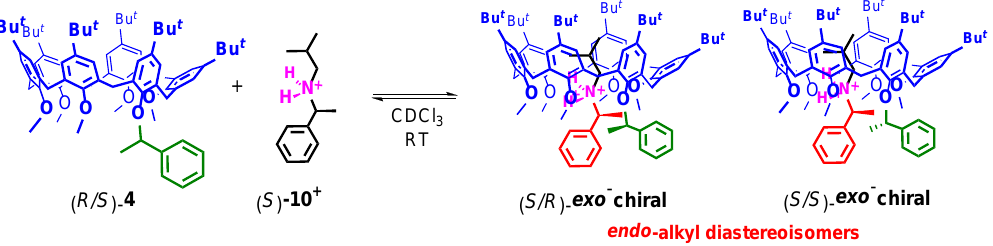
Scheme 7. Formation of the two “ exo -chiral” ( S )- 10 + @ ( R/S )- 4 pseudo[2]rotaxane diastereoisomers. The 1 H NMR spectrum of a 1:1 mixture (3 mM) of ( R/S )- 4 with ( S )- 10 + ∙[B(Ar F ) 4 ] − salt in CDCl 3 at